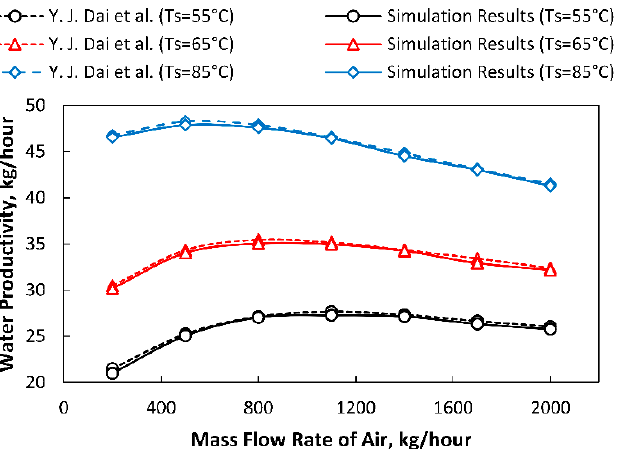
Figure 5. Benchmarking of simulation results by comparison with simulation results of Dai et al. [75] without waste heat recovery.